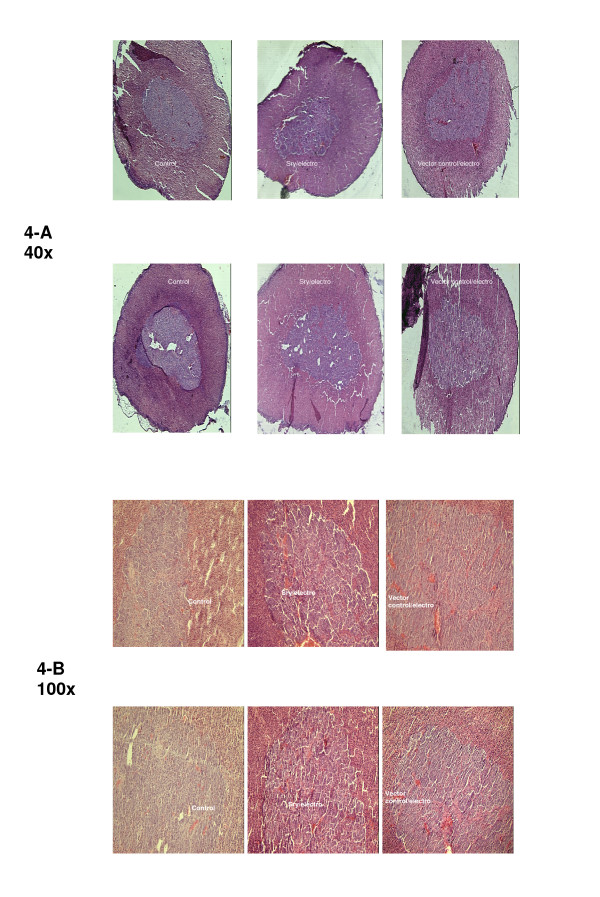
Adrenal gland morphology is unchanged by the electroporation protocol. A panel-40×, B panel-100×, of representative animals that had nothing done-(left panels, control), had Sry delivered by electroporation (middle panels, Sry/electro) or empty vector delivered (right panels). The lighter color purple in the middle of the tissue is the medulla. The holes or cracks in the medulla are not defects but tears in the tissue from processing. Gene or empty vector delivery did not disrupt tissue morphology.